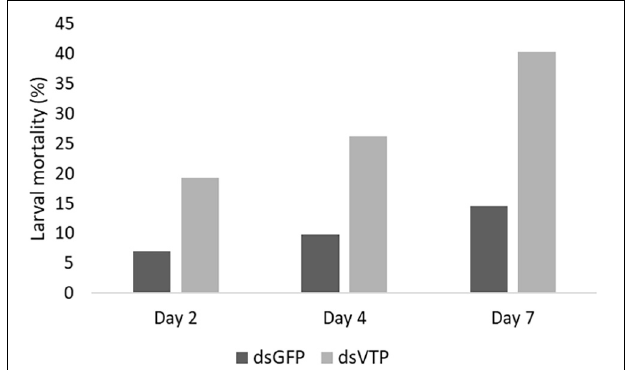
FIGURE 6 | Mortality cumulative of Anastrepha fraterculus larvae ( n = 57) after soaking in dsRNA solution (500 ng/ µ l) from V-ATPase (ds VTP ) and GFP control (ds GFP ) at 2, 4, and 7 days.